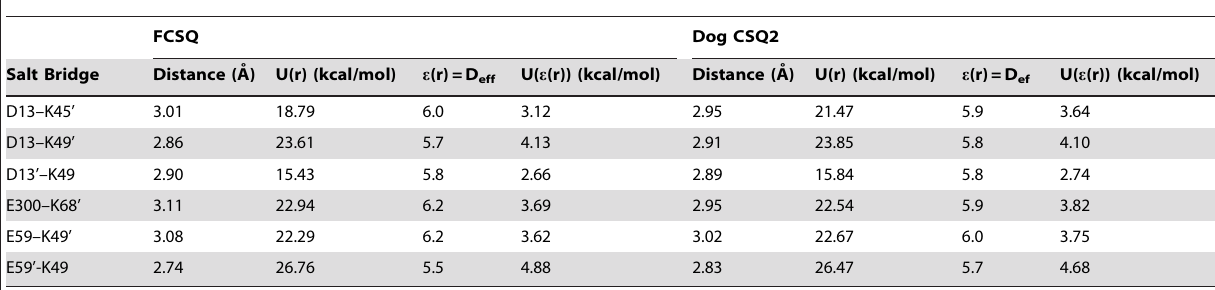
Table 2. Intermonomeric salt bridges of FCSQ and DCSQ2.